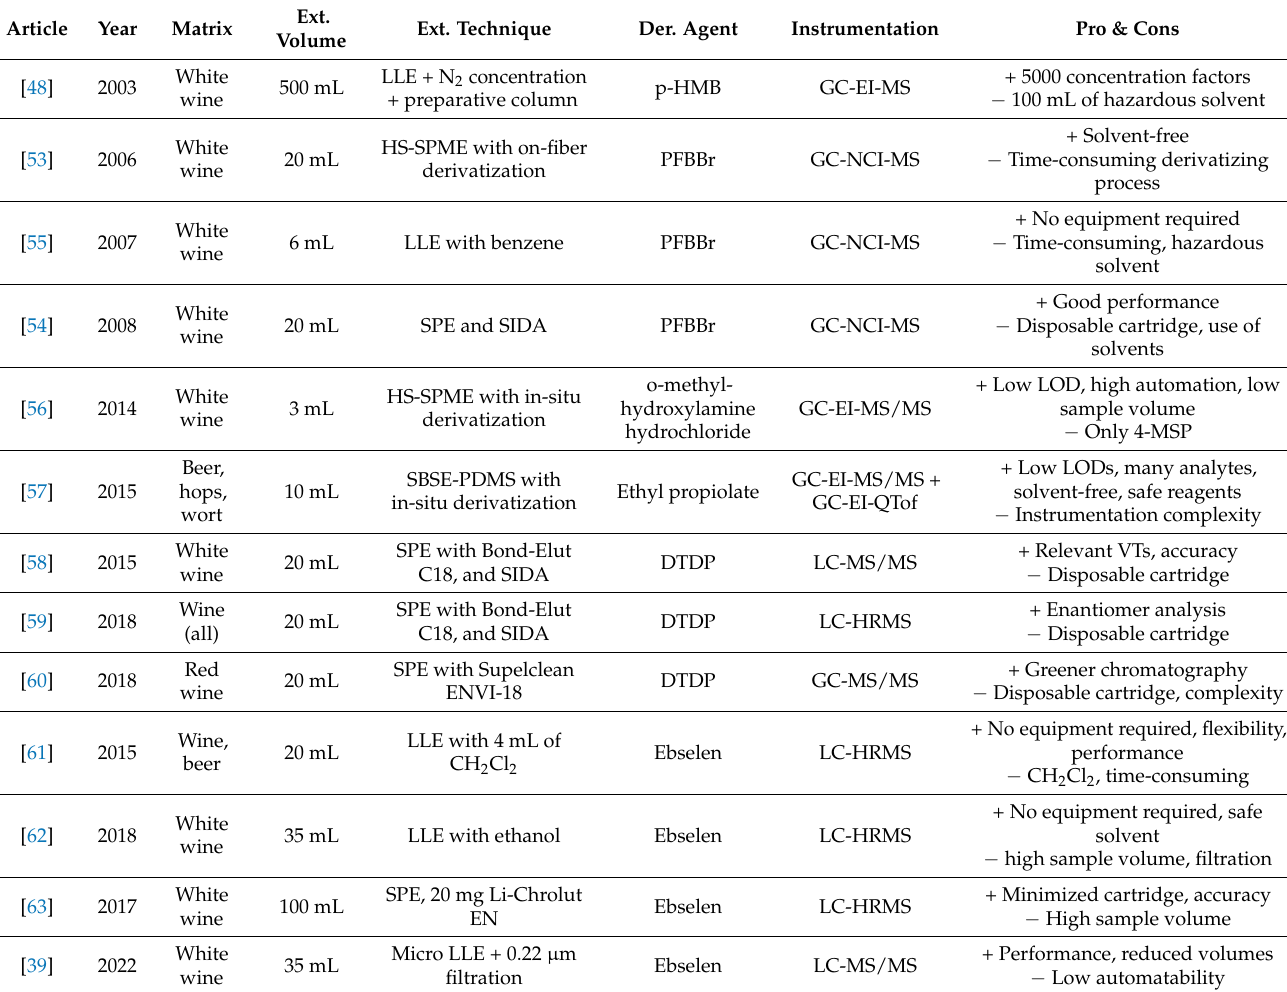
Table 1. GC-MS and LC-MS methods presented for VTs’ determination and related